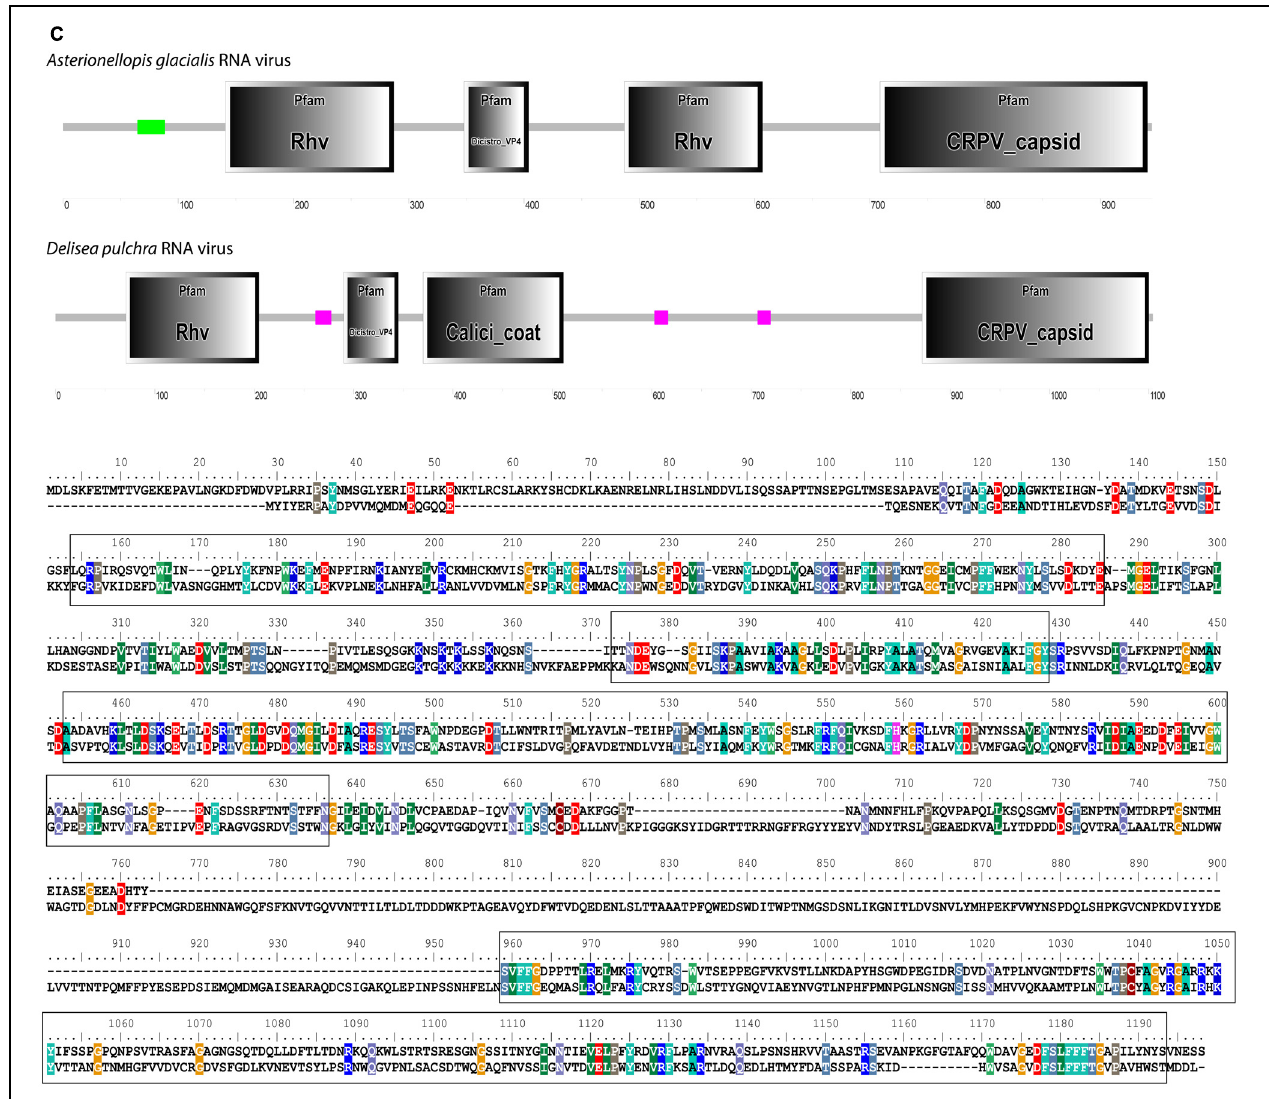
FIGURE 3 | Continued (A–C) Comparison between the Asterionellopis glacialis (“Agla”) RNA virus and the D. pulchra RNA virus. (A) The genomes of both viruses encode two polyproteins, one replication associated and one structural polyprotein. (B) Protein domain analysis using SMART (Simple Modular Architecture Research Tool) and sequence alignment of the replication associated polyprotein shows a similar structural organization consisting of RNA helicase or replication associated protein AAA, transmembrane proteins (blue boxes) and RdRP. Low complex regions are shown in pink. (C) Protein domain analysis and sequence alignment of the structural polyprotein shows four structural protein domains Rhv, DicistroVP4, Calici coat, and CRPV capsid. The Calici coat domain overlaps with the second Rhv domain of the Agla RNA virus. Sequences of conserved protein domains are highlighted in